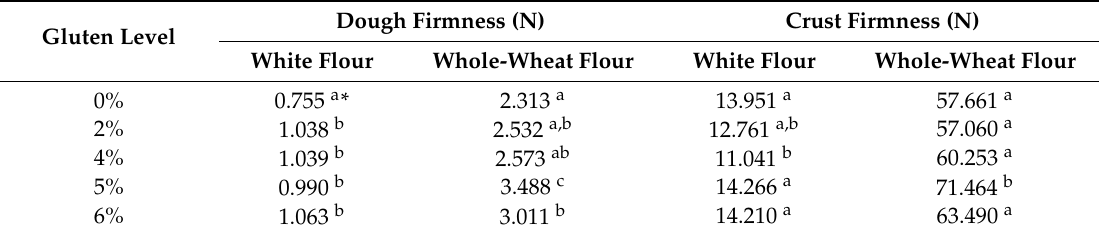
Table 1. Average values (during storage of 111 days for white flour samples and 110 days for whole flour samples) of dough and crust firmness.